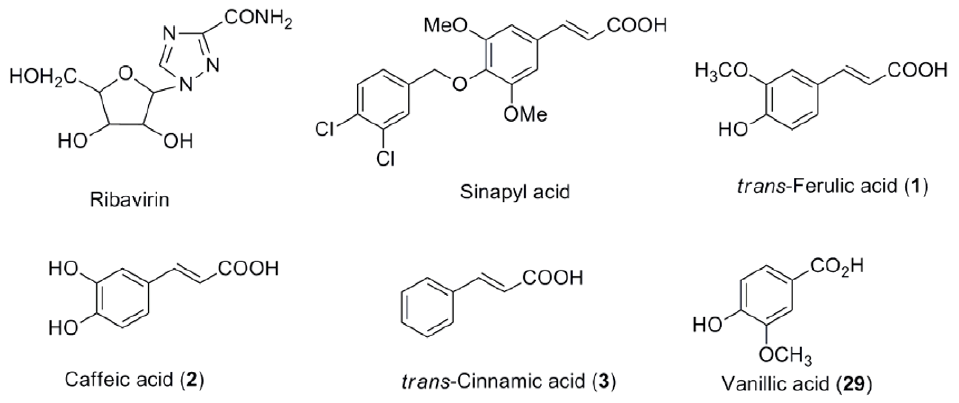
Figure 1. Chemical structure of Ribavirin, acrylic acids 1–3 and acid 29.